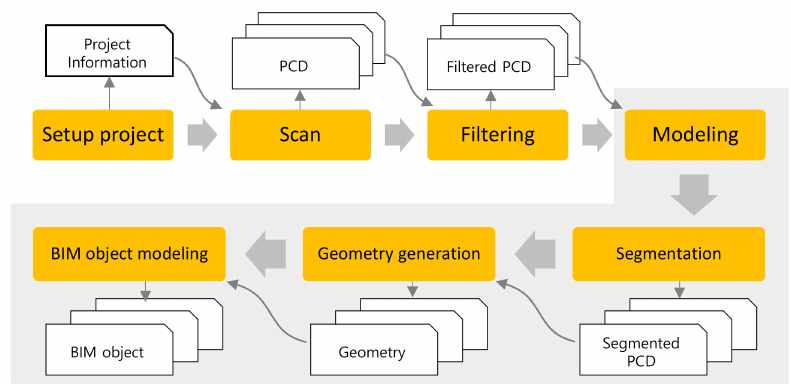
Figure 3. Scan-to-BIM Pipeline Component and Input / output